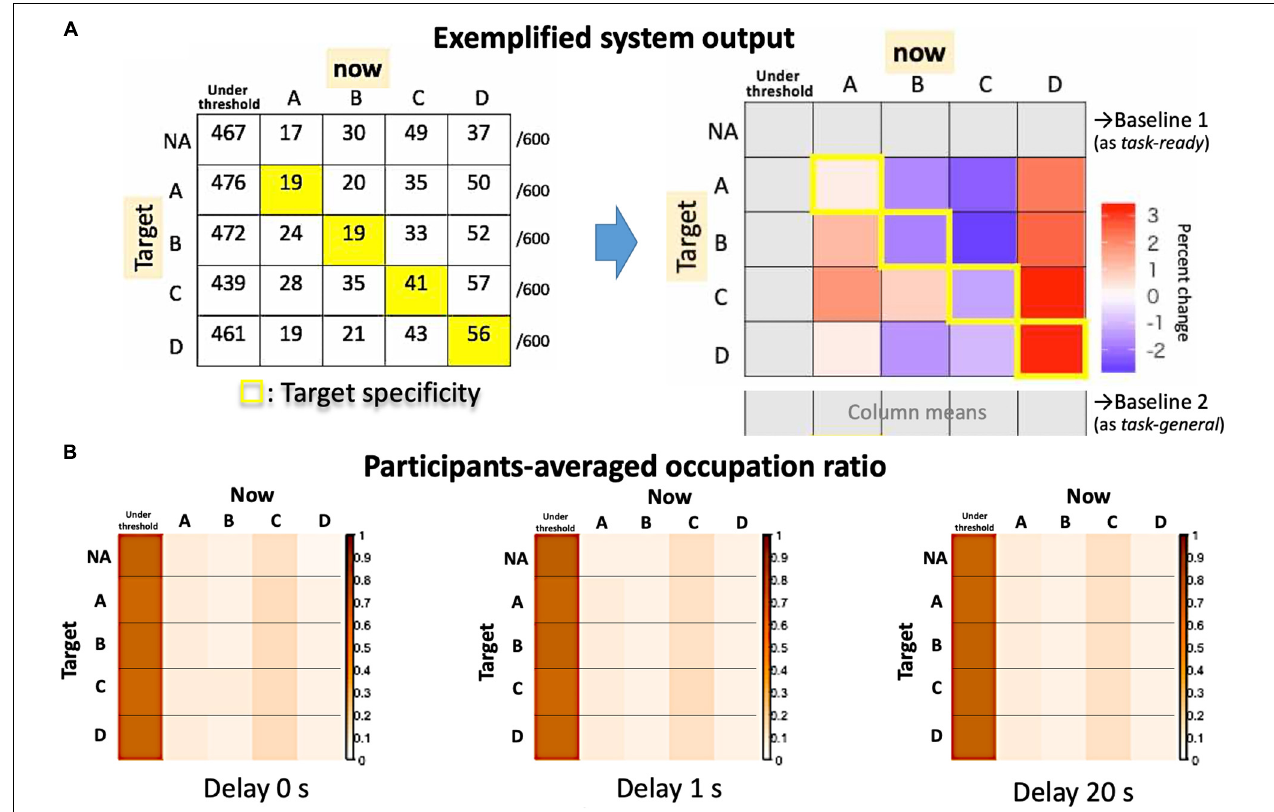
FIGURE 8 | System outputs as an asymmetrical matrix. (A) The raw counts for an exemplified session (left) and the summarized matrix for the target specificity are shown in contrast to possible baselines (right). (B) Actual participants’ averages as occupation ratios for each delay